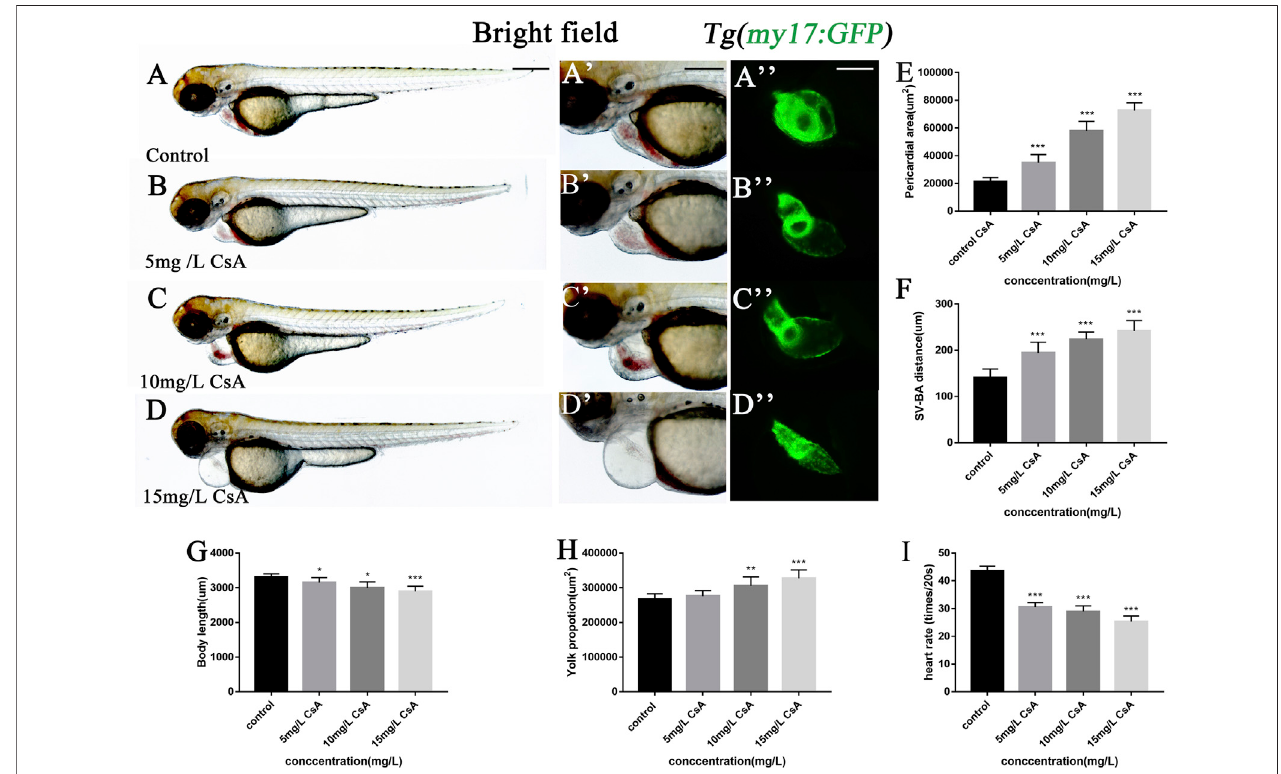
FIGURE1| ExposuretoCsAinducedcardiacdevelopmentaltoxicityinzebra fi shembryos. (A-D) Tg(my17:GFP)transgeniclineswereexposedto5 mg/L,10 mg/ L,and15 mg/LCsAfrom12 hpfto72 hpf (E) Thepericardialareaofjuvenilezebra fi shat72 hpfexposedto5 mg/L,10 mg/L,and15 mg/LCsA.( n (cid:1) 15.Comparedwith control: * p < 0.05, *** p < 0.001, mean ± S. D). (F) The distance of SV-BA of juvenile zebra fi sh at 72 hpf exposed to 5 mg/L, 10 mg/L, and 15 mg/L CsA ( n (cid:1) 15. Compared with control:*** p < 0.001, mean ± S. D). SV: sinus vein; BA: artery bulb; scale: 100 mm. (G) The body lenth of juvenile zebra fi sh at 72 hpf exposed to 5 mg/L, 10 mg/L, and 15 mg/L CsA (n (cid:1) 15. Compared with control: *** p < 0.001, mean ± S. D). (H) Yolk sac area of zebra fi sh embryos at 72 hpf exposed to 5 mg/L, 10 mg/L, and 15 mg/L CsA ( n (cid:1) 15. Compared with control: * p < 0.05, mean ± S. D) (I) The heart rate of juvenile zebra fi sh at 72 hpf exposed to 5 mg/L, 10 mg/L, and 15 mg/L CsA ( n (cid:1) 15. Compared with control:*** p < 0.001, mean ± SD).Scale bars:500 µm (A-D) , 100 µm (A-D)